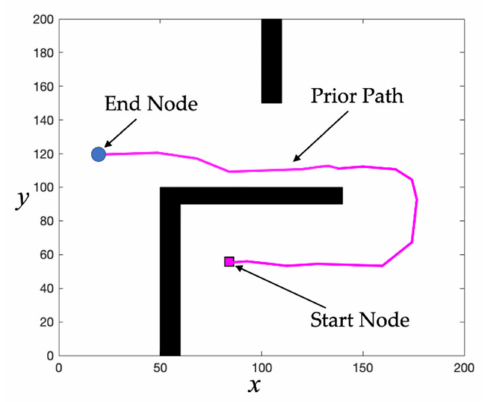
Figure 15. Case Study